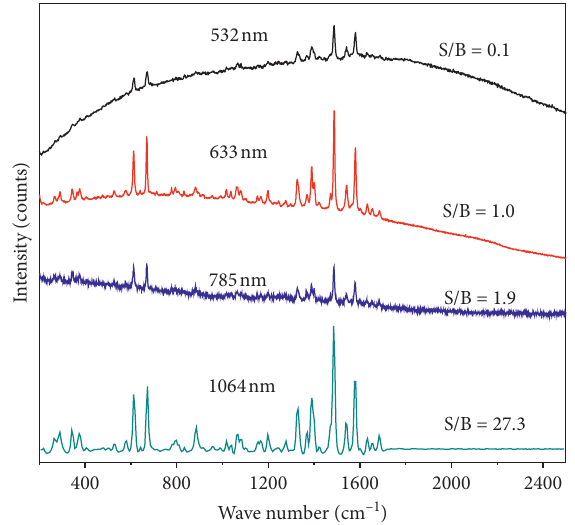
Figure 1: Raman spectra of ETV-H obtained by different excitation